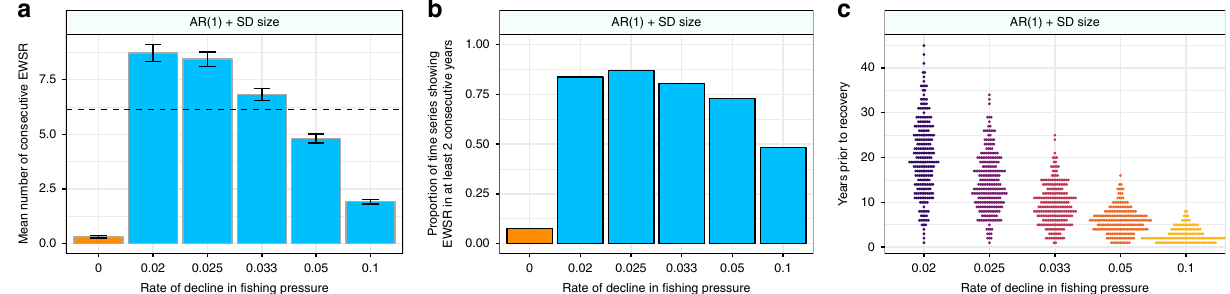
Fig. 5 Ef fi cacy of consecutive warning signals in predicting the recovery of cod populations. a Mean maximum number of consecutive EWSR for the metric with the highest mean maximum number across all the recovery simulations (blue bars, AR(1) + SD size) at a 2 σ threshold. While those populations which did not recover did show some EWSR (orange bar), they typically did not show them in consecutive years, whereas those populations that did recover showed signals at a 2 σ threshold in – on average – 6 consecutive years across the recovery treatments (horizontal black line). b Proportion of populations showing EWSR in at least 2 consecutive years at a 2 σ threshold. Error bars show 1 SE. c Distribution in time of EWSR based on 2 consecutive signals at a 2 σ threshold for the metric with the biggest difference in the number of consecutive signals between recovery and non-recovery treatments (AR(1) + SD size, Fig. 5). EWSR were detectable – where change in the pressures exerted upon a system is slow – up to 43 years prior to the recovery of the populations